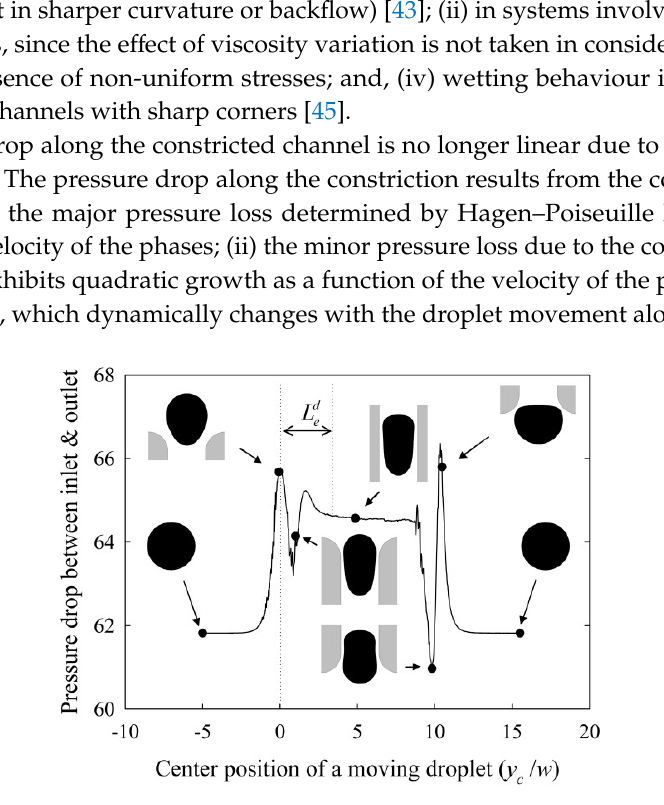
Figure 2. Pressure drop in a constriction between inlet and outlet with X = 1 and Ca = 0.1. L d e is the entry length (i.e., the moving distance of the droplet since it enters the constriction until the pressure becomes constant), w the constriction microchannel width, and y c the centre position of the moving droplet along the microchannel. Reproduced with permission from [46].